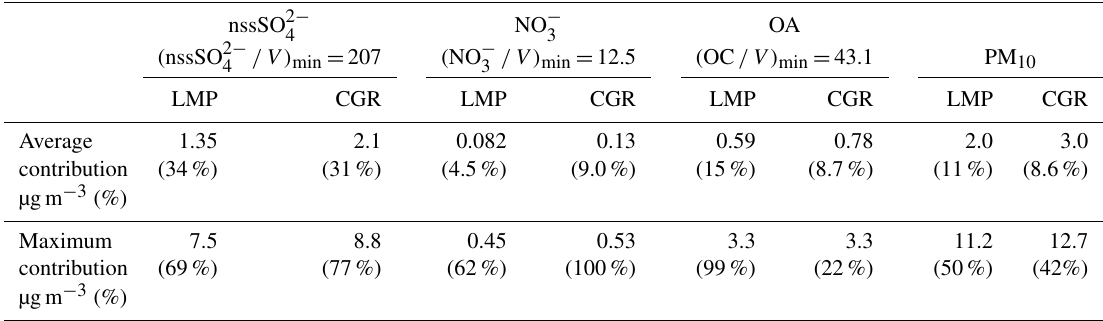
Table 4. Estimates of the average and maximum of the lower limit of nssSO 2 − percent with respect to the total amount of each species are reported. The maxima are derived by selecting cases with the largest ship impact (i.e. highest V